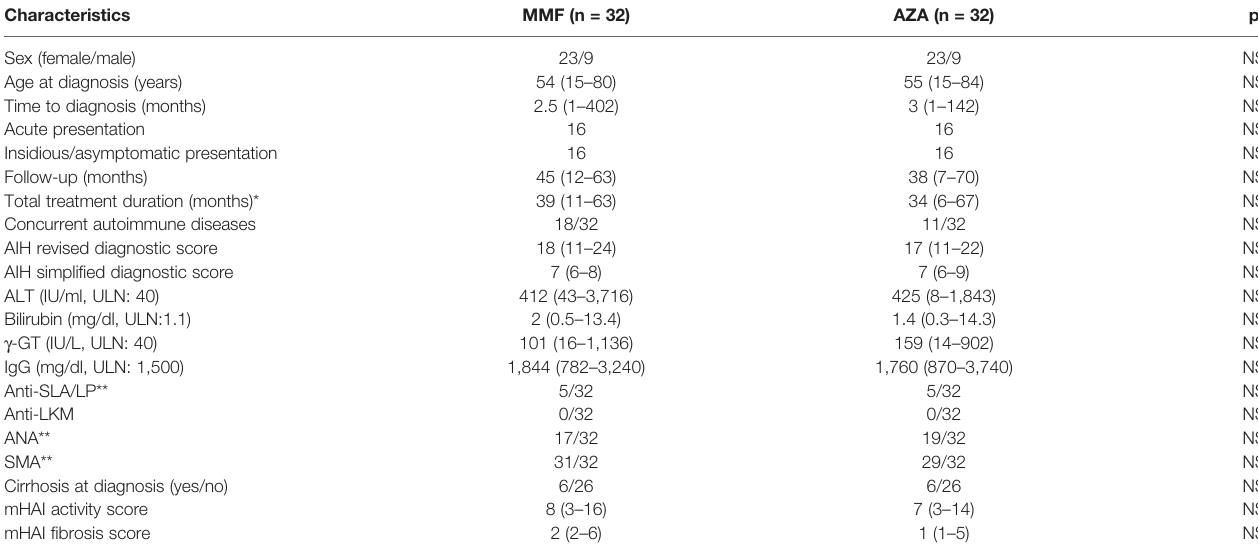
TABLE 2 | Baseline demographics, clinical, laboratory, serological, and histological characteristics in the two groups of the study.